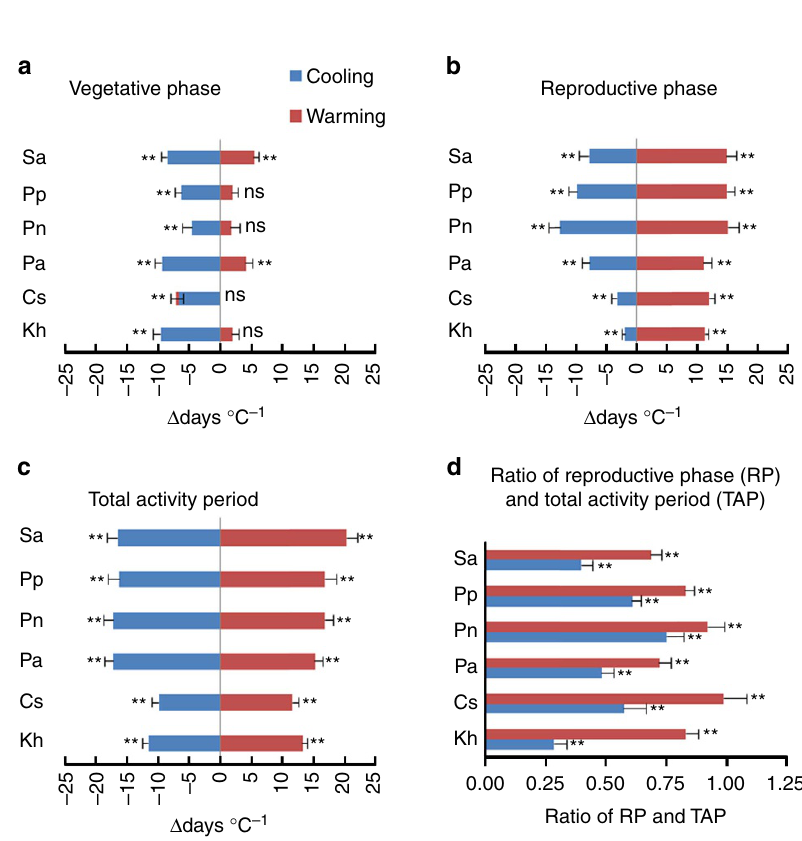
Figure 2 | Temperature sensitivity of duration change of phenological events. The panels include the vegetative phase ( a ), reproductive phase ( b ), activity period ( c ) and their ratios of reproduction to activity period ( d ) under warming and cooling conditions. A t -test was used for each phenological event and species, and the a was adjusted following a Bonferroni correction. The mean value of phenological sensitivity in each plot in each year was the unit of replication ( n ¼ 45 for each t -test under warming and cooling conditions, respectively). Kh, K. humilis ; Cs, C. scabrirostris ; Pa, P. anserine ; Pn, P. nivea ; Pp, Poa pratensis ; and Sa, S. aliena . D days was the difference between receptor site (that is, away site) and donor site (that is, home site). Positive values indicate a prolonged phenological stage and negative values a shortened phenological stage when transferred compared with donor site. Means ± s.e. are shown in the figure. ‘*’, ‘**’ in the figure are the significant difference at 0.004 and 0.0008 levels between receptor site and donor site. All P values were o 0.0001 except vegetative phase for Kh, Cs, Pn and Pp under warming, which were 0.031, 0.727, 0.002 and 0.101, respectively. NATURE COMMUNICATIONS|7:12489|DOI: